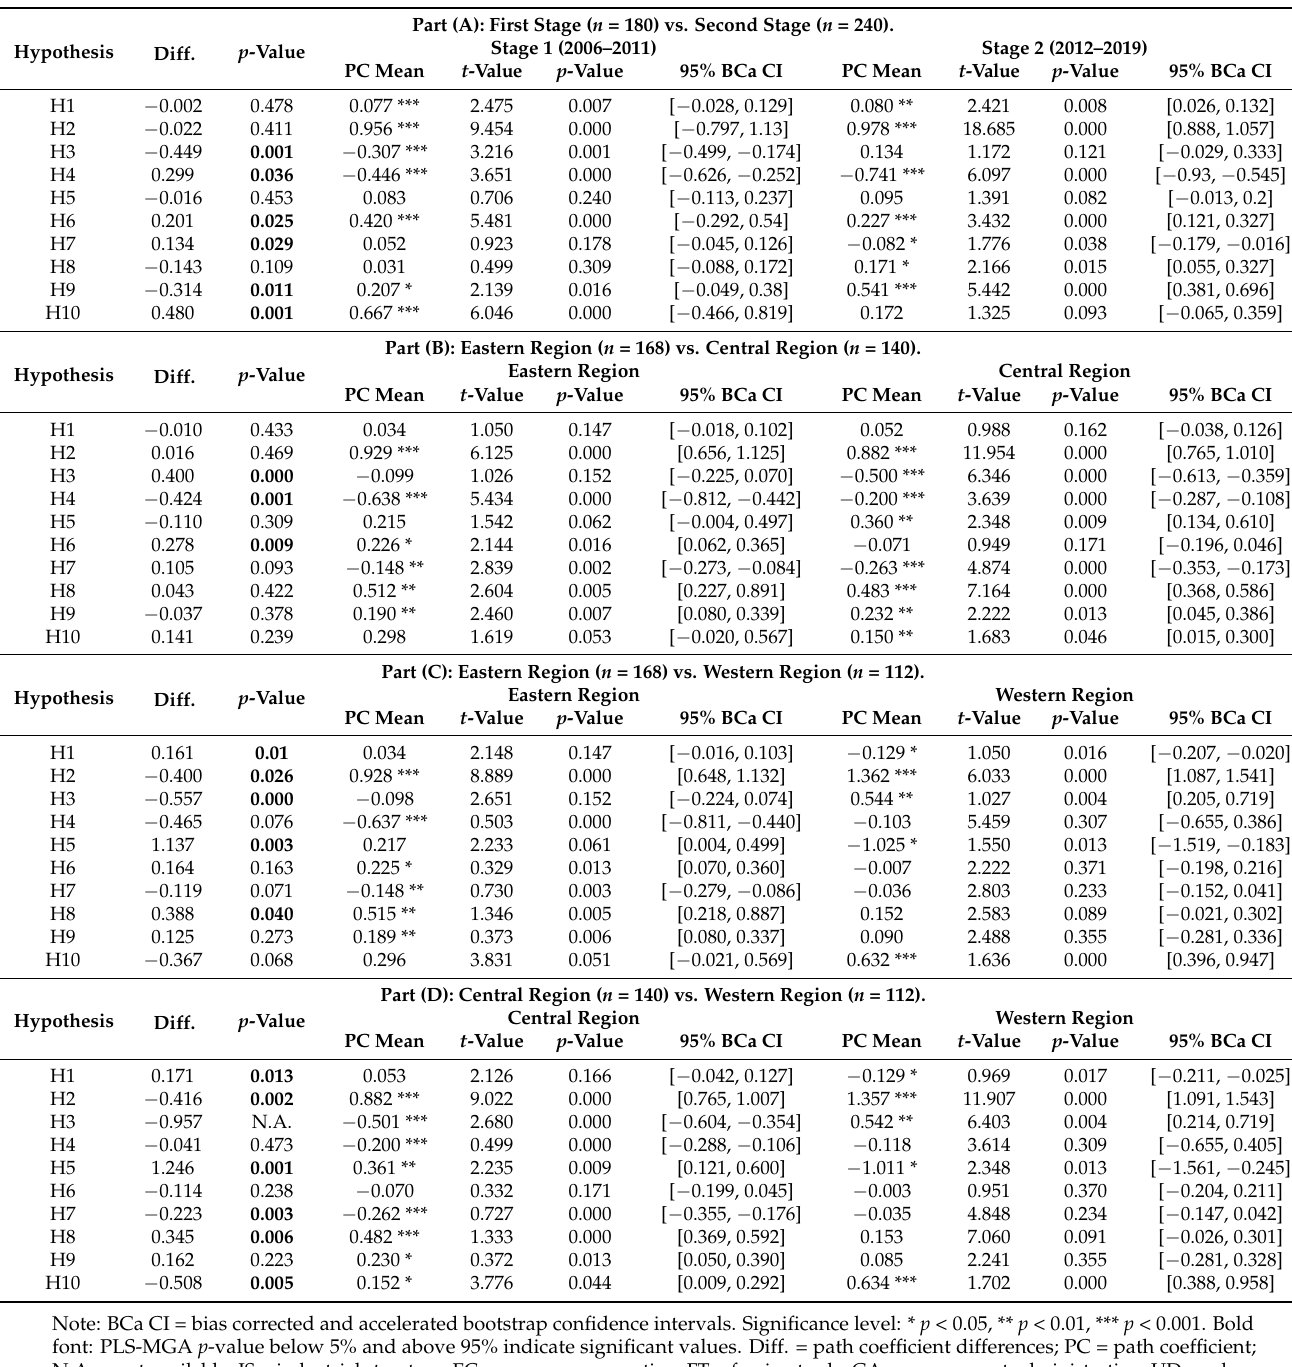
Table 5. Results of multigroup analysis on different periods and regions in